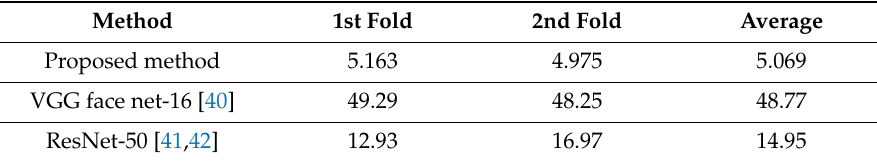
Table 13. Comparison of EER for recognition results via the proposed method and previous face recognition methods (unit: %).